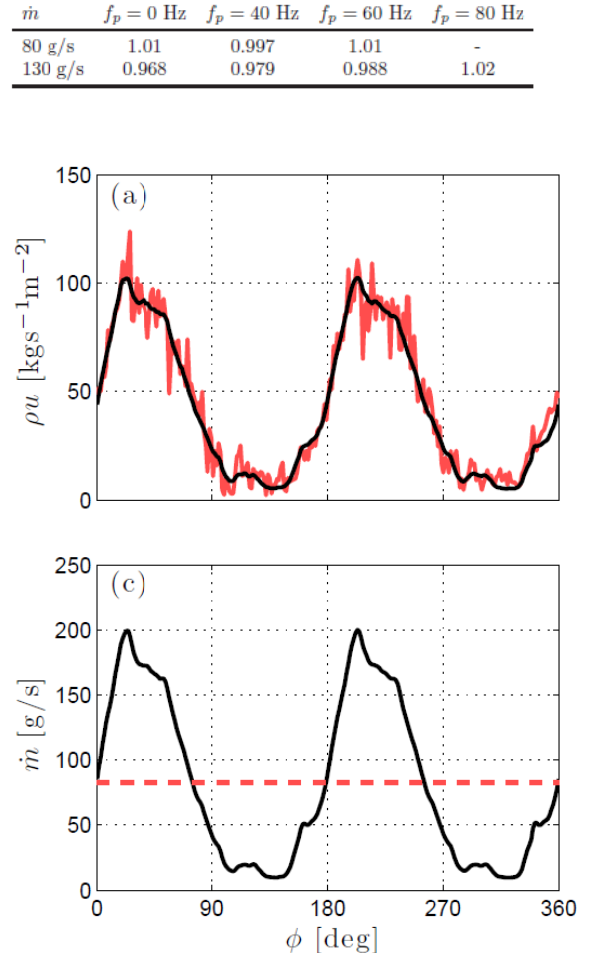
Fig. 3. Resulting mass flow rate measurements by hot-wire method (varying solid line, top chart) compared with phased averaged value (bold black solid line, both charts) and integrated mass flow rate (dashed line, bottom chart) for various pulse phases (horizontal axis) [6].